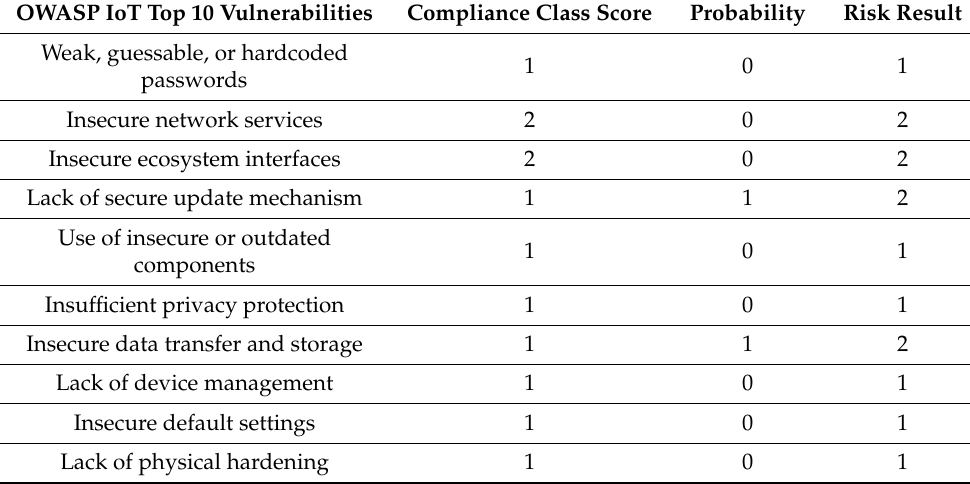
Table 20. Case study risk post-hardening.